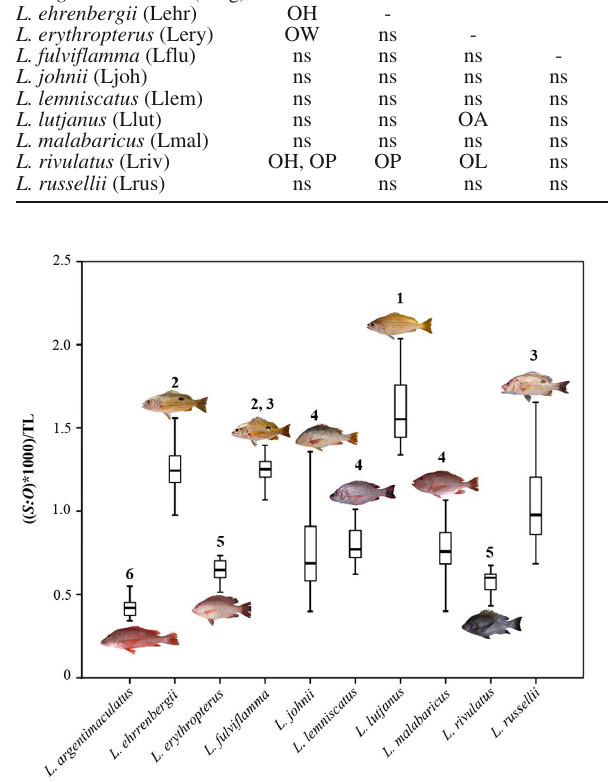
Fig . 4. – Box plots (maximum, minimum, upper and lower quar tiles) for the sulcus acusticus area: otolith area ratio (S:O) for snappers from the Persian Gulf. Numbers indicate the corresponding group.